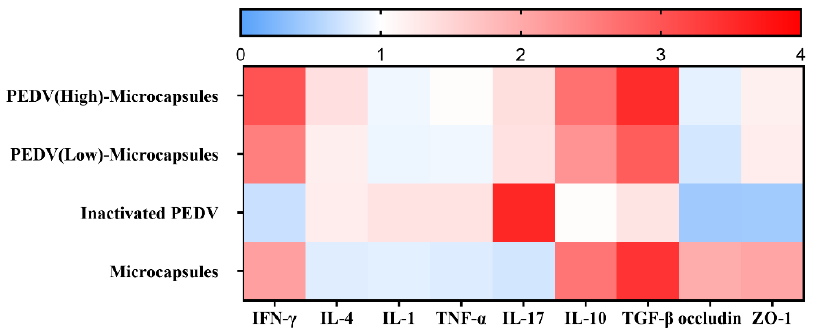
Figure 5. The expression analysis of genes by qRT-PCR analysis. For the expression analysis of genes, blue and red indicate decreased and increased expression, respectively. For qRT-PCR analysis of the expression of randomly selected novel genes from the immune and tight junction, data are presented as mean ± S.D. (n = 3).